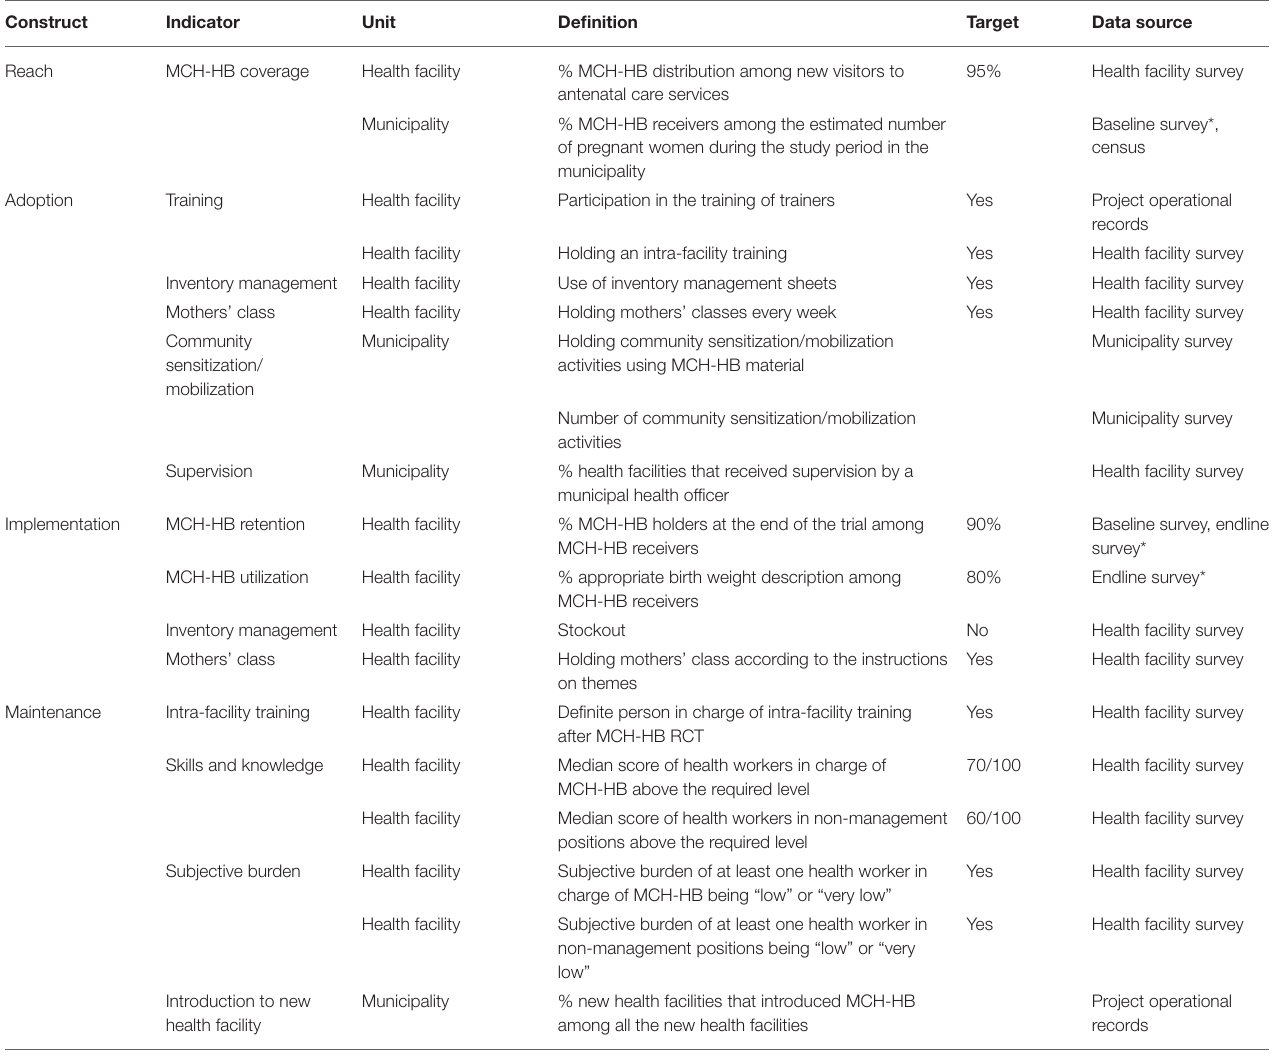
TABLE 2 | Implementation variables and constructs.